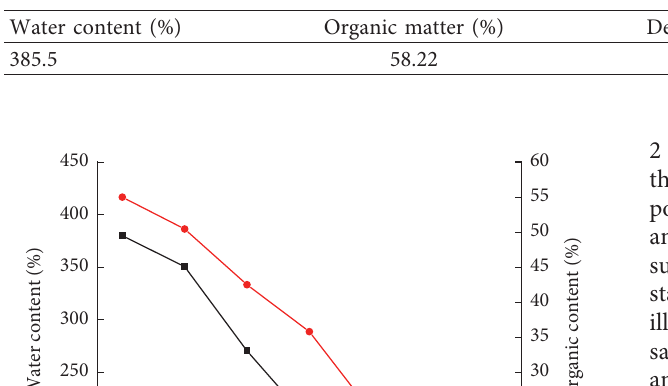
Table 2: Basic physical properties of municipal sludge.